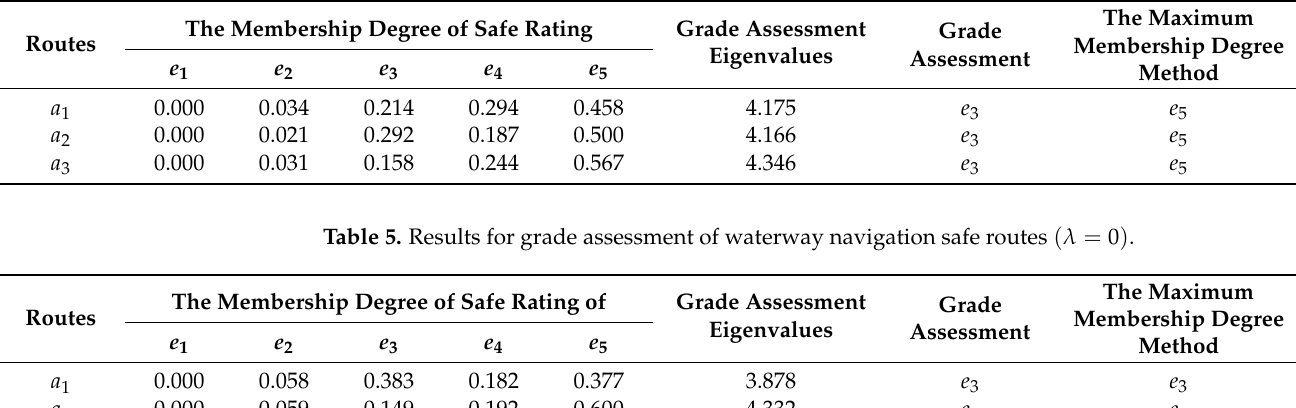
Table 4. Results for grade assessment of waterway navigation safe routes ( λ = 1 ) .